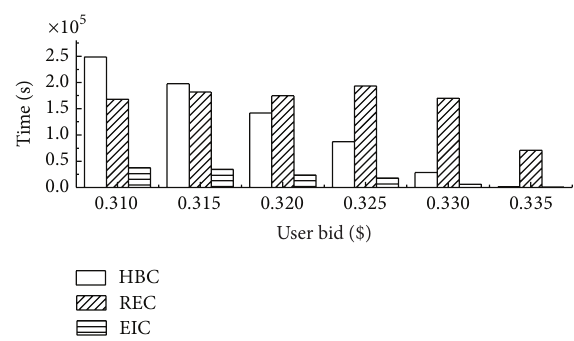
Figure 14: Comparison of rollback time according to user bid.